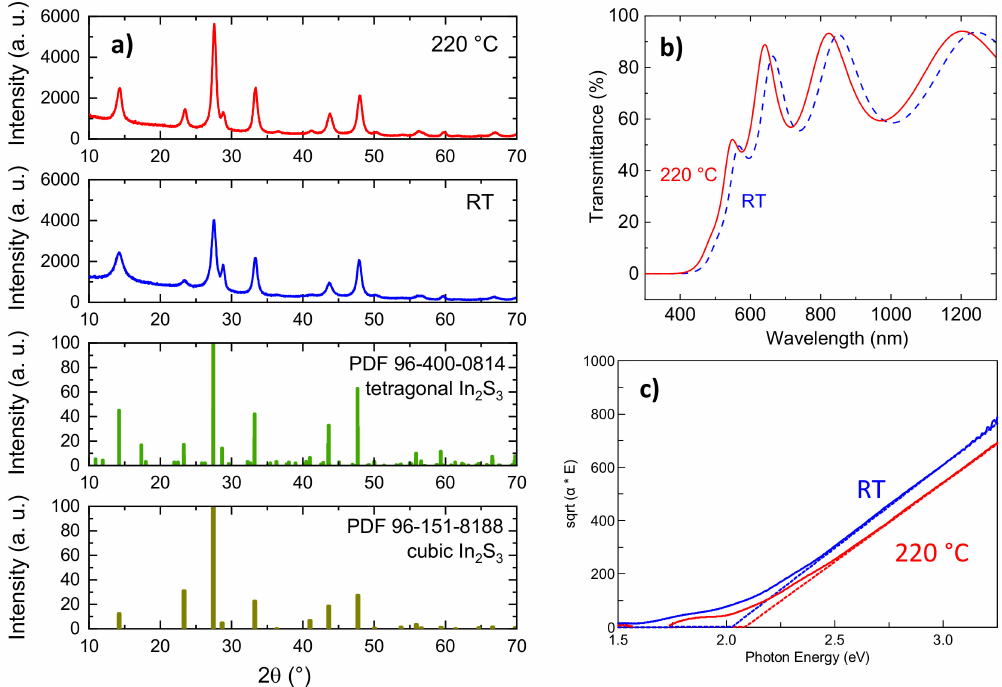
Figure 3. ( a ) GIXRD patterns measured with an incident angle of 0.5 ◦ on approximately 500 nm thick In x S y layers on suprasil quartz glass; ( b ) Transmittance measurement of about 500 nm thick In x S y layers on suprasil quartz glass; ( c ) Corresponding sqrt( α E )- E -plot ( indirect bandgap energy for extraction of E g value was